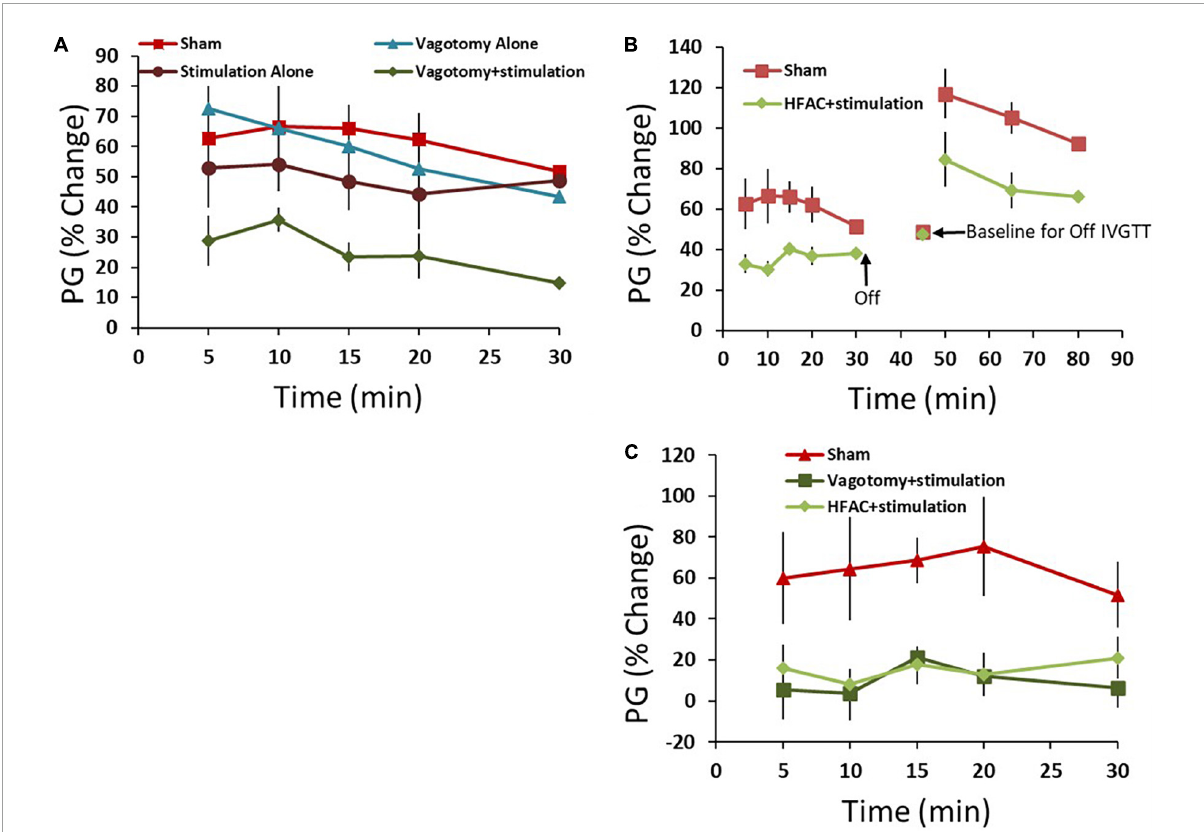
FIGURE6 High frequency alternating current applied to the hepatic branch of the vagus nerve with simultaneous stimulation of the celiac branch of the vagus nerve reversibly decreased plasma glucose (PG) following an intravenous glucose tolerance test (IVGTT) in control and Zucker obese (fatty) male (ZDF) rats compared to sham. (A) As a positive control the hepatic nerve was ligated [in place of application of high frequency alternating current (HFAC)] with concurrent stimulation of the celiac nerve. This produced increased glycemic control compared to sham following an IVGTT. Standalone celiac nerve stimulation or hepatic nerve ligation had the same response to the IVGTT as sham. (B) Similar to vagotomy + stimulation, the application of HFAC + stimulation increased glycemic control following the IVGTT compared to sham. A subsequent IVGTT 15 min following the cessation of HFAC + stimulation demonstrated decreased glycemic control; suggesting reversibility. (C) Control Sprague Dawley rats also demonstrated increased glycemic control with HFAC + stimulation and vagotomy + stimulation. Error bars are